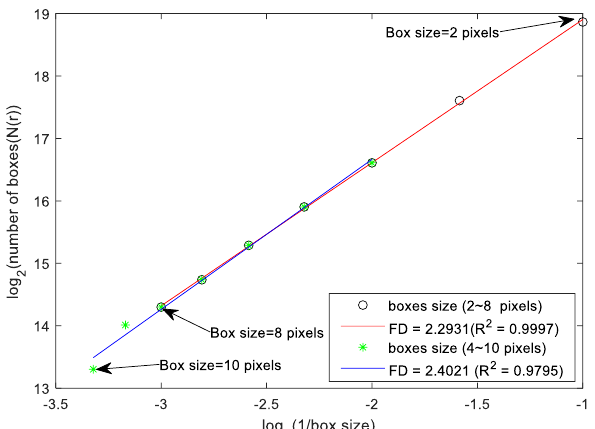
Figure 1. FD measure estimation. Log-log scatter plot, where the x and y axis denote the inverse of the box size and the number of boxes in the logarithmic scale, respectively. The FD value is the slope of the fitting line.